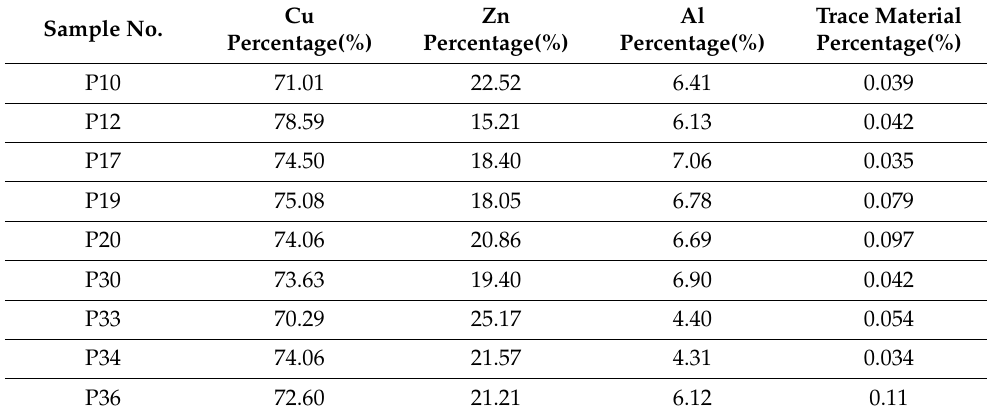
Table 1. The weight percentages of metal from the composition of the samples made of Cu–Al–Zn alloy. Sample No.